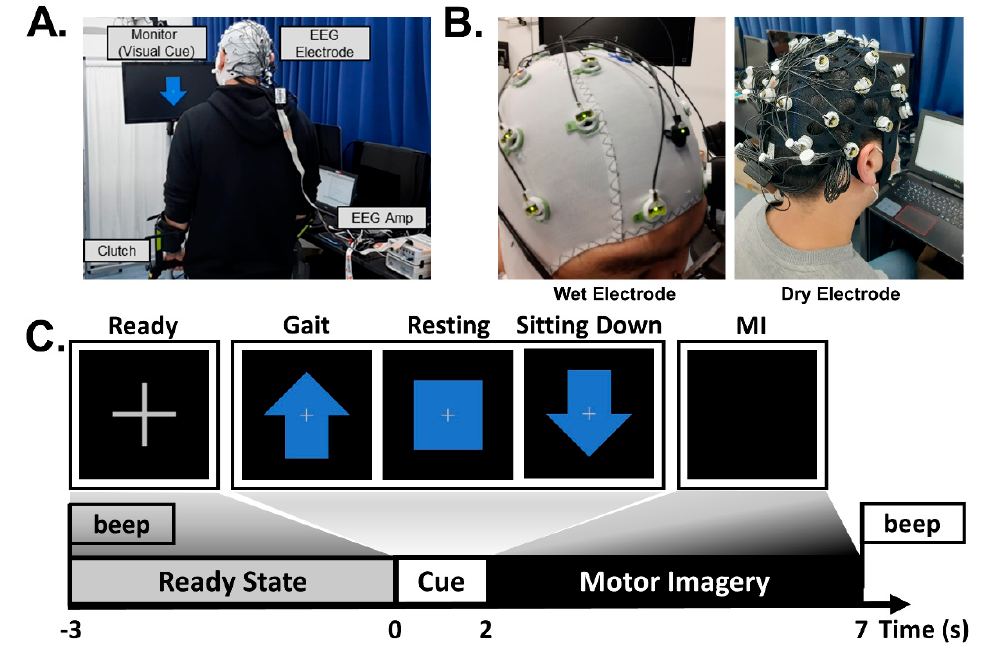
Figure 2. Schematic overview of the experimental protocol and setup. ( A ) Experimental environments and setup. ( B ) The two types of electrodes used in this study. ( C ) Experimental protocol of the two sessions: dry and wet electrode BCI.